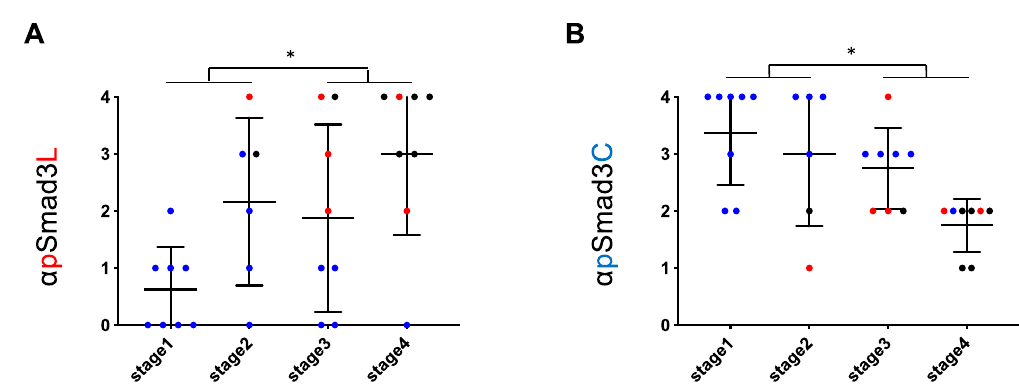
Figure 4. Although hepatocytic Smad phospho ‐ isoform signaling shifted from the pSmad3C pathway to the pSmad3L pathway during chronic liver disease progression in nonalcoholic steatohepatitis (NASH), Smad3 phospho ‐ isoforms of NASH livers varied more widely than those of hepatitis C virus (HCV) ‐ infected livers throughout all fibrotic stages. ( A ) Extent of hepatocytic phosphorylation at Smad3L tended to increase in proportion to fibrotic stage in NASH livers. Phosphorylation of Smad3L in the hepatocytes of highly fibrotic livers (F3 to F4) was greater than in livers with grade F1 to 2 fibrosis. ( B ) Extent of hepatocytic phosphorylation at Smad3C tended to decrease in proportion to fibrotic stage in NASH livers. Phosphorylation of Smad3C in the hepatocytes of highly fibrotic livers (F3 to F4) was lower than those in livers with grade F1 to 2 fibrosis. * p < 0.05 NASH livers were divided into four fibrotic stages. Smad3 phosphorylation in NASH livers was scored from 0 to 4 as described in Methods. Dods ( ● ) represent pSmad3L ( A ) and pSmad3C ( B ) positivity for each liver specimen. Blue, red and black colors indicate hepatocytes from which hepatocellular carcinoma (HCC) had not developed, HCC developed during the following period, and HCC already existed at liver biopsy, respectively. Horizontal bars indicate mean phospho ‐ Smad3 positivity in each group.